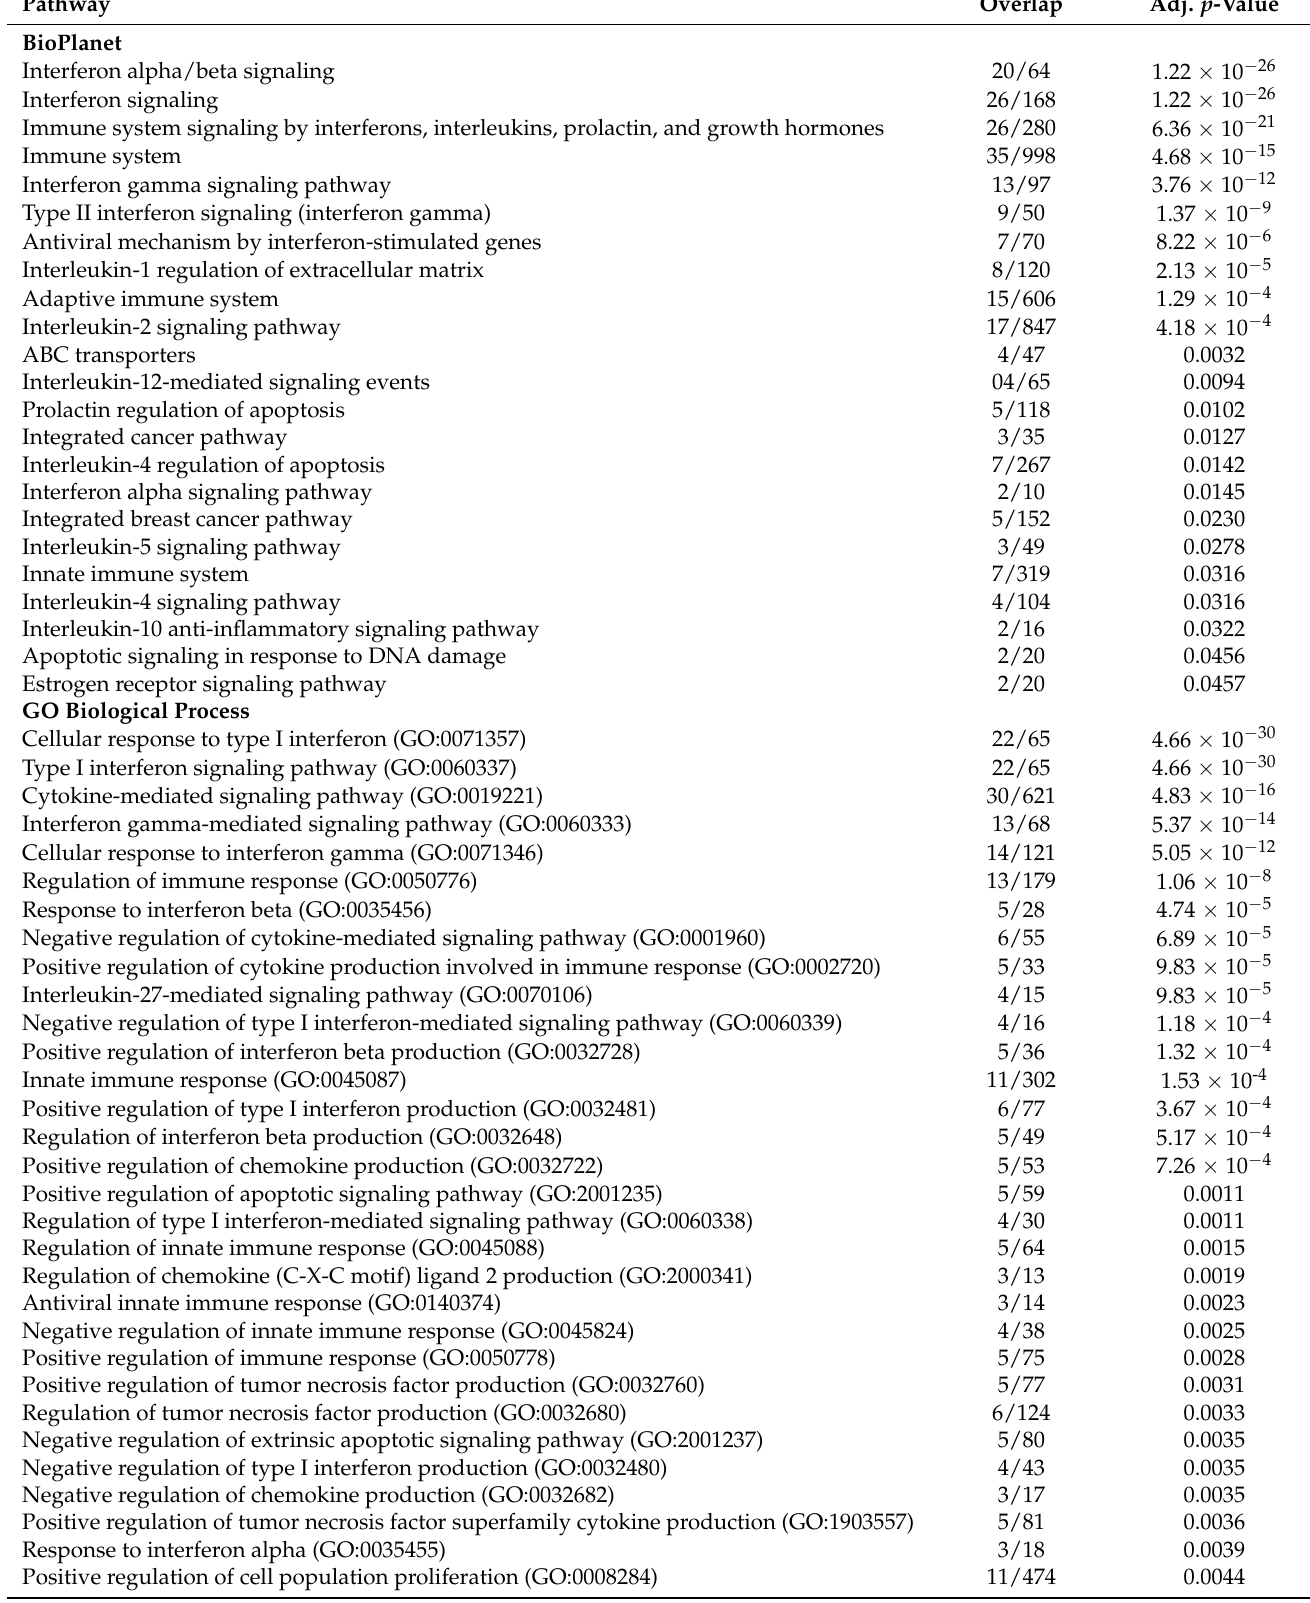
Table 3. Pathway enrichment analysis of DRGs in spheroids transfected with miR193a and the mimic